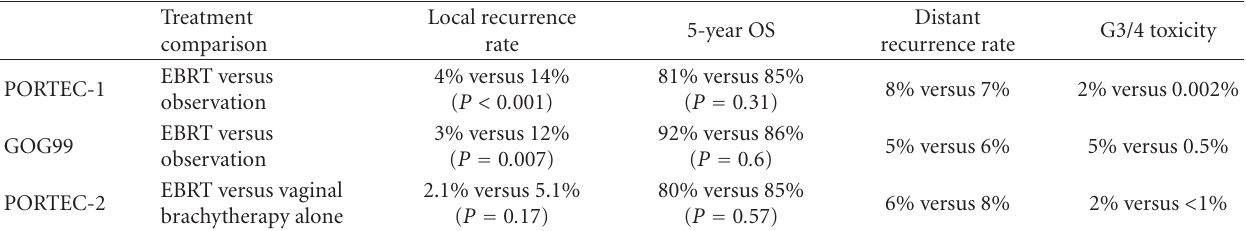
Table 3: Some important randomized trials comparing external beam radiation therapy to observation or vaginal brachytherapy alone.